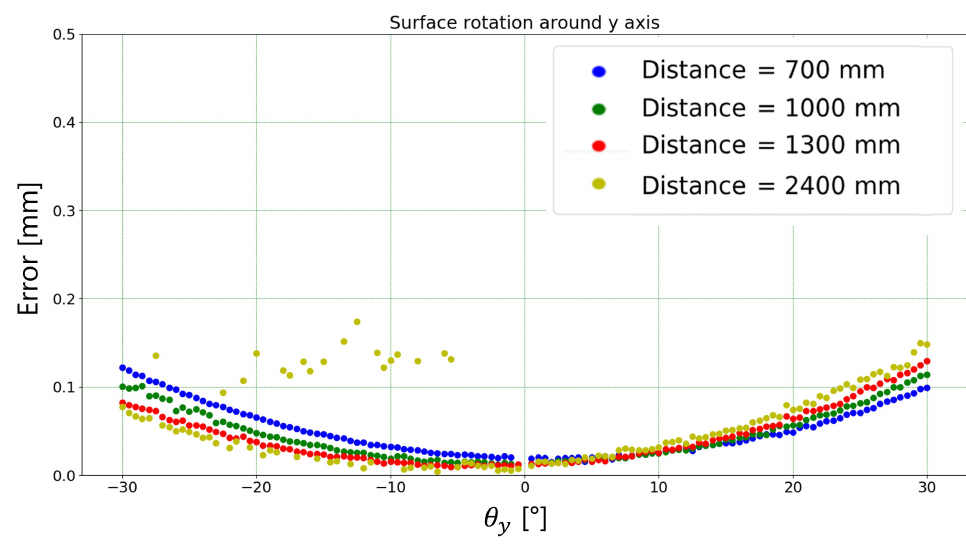
Figure 19. Absolute error (i.e., difference between mean width measured by the proposed algorithm and the target width) in mm for each rotation angle (around y axis) and each working distance tested.